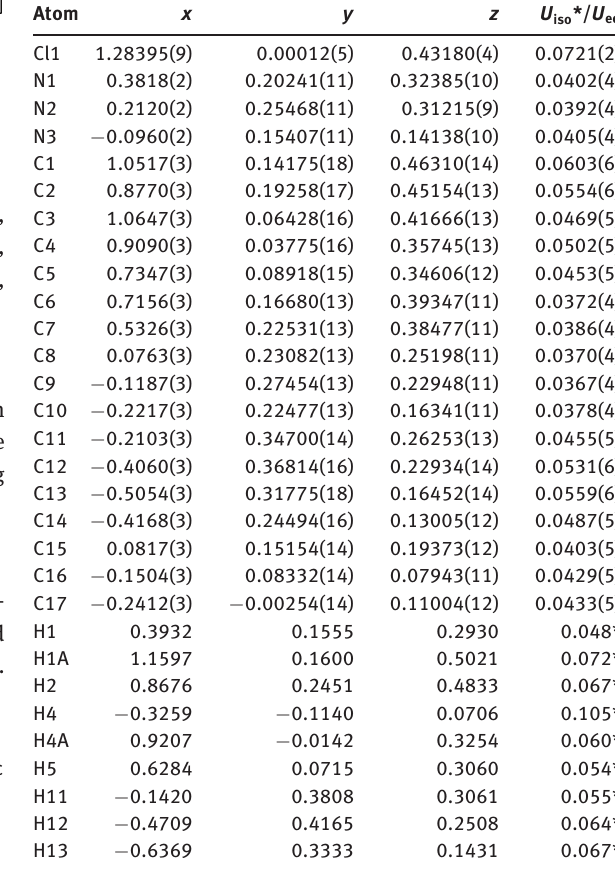
Table 2: Fractional atomic coordinates and isotropic or equivalent isotropic displacement parameters (Å 2